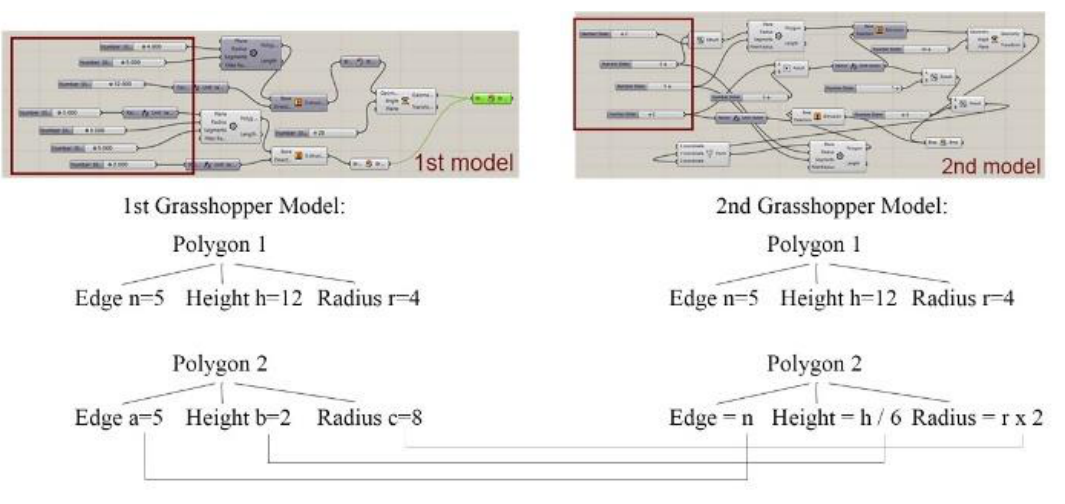
Figure 8. Differences between first and second Grasshopper models of a student.